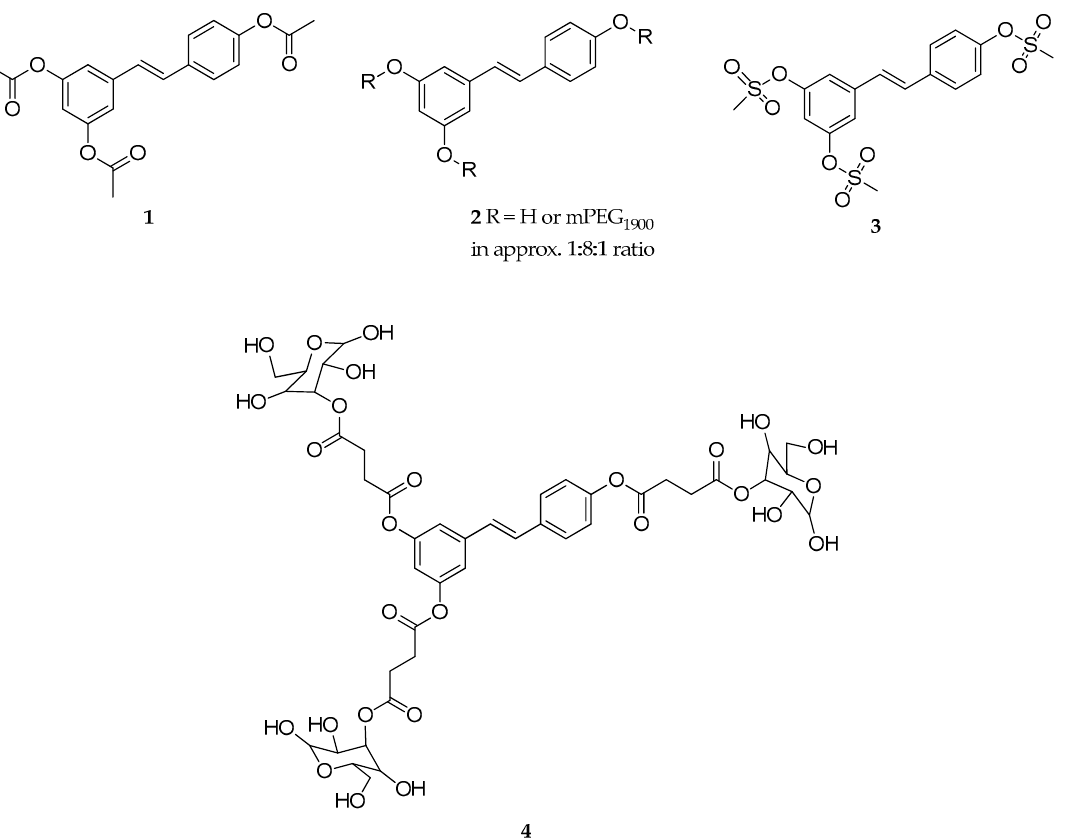
Figure 4. Chemical structures of RSV triacetate ( 1 ), RSV tri-mPEG 1900 ( 2 ), RVS trimesylate ( 3 ), and 3,5,4 ′ -tri( α -D-glucose-3-O-succinyl)-resveratrol ( 4 ).